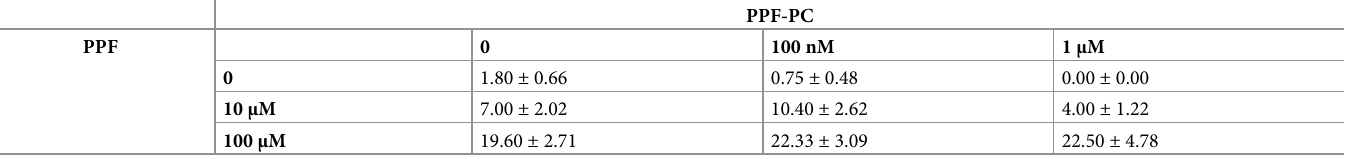
Table 1. The number of neurons that had FMax > 1.5 in 50